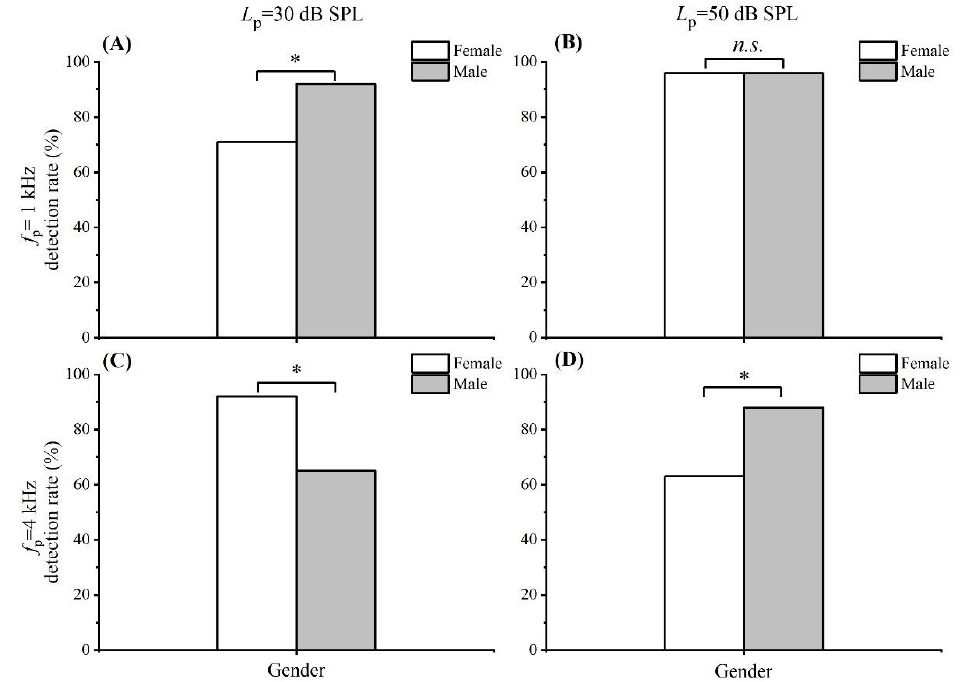
Figure 2. The detection rates of SFOAE between groups of female and male under four conditions: 2 probe levels × 2 probe frequencies. (A) f p = 1 kHz; L p = 30 dB SPL; (B) f p = 1 kHz; L p = 50 dB SPL; (C) f p = 4 kHz; L p = 30 dB SPL; (D) f p = 4 kHz; L p = 50 dB SPL. * p < 0.05, n.s ., not significant (chi-square tests).